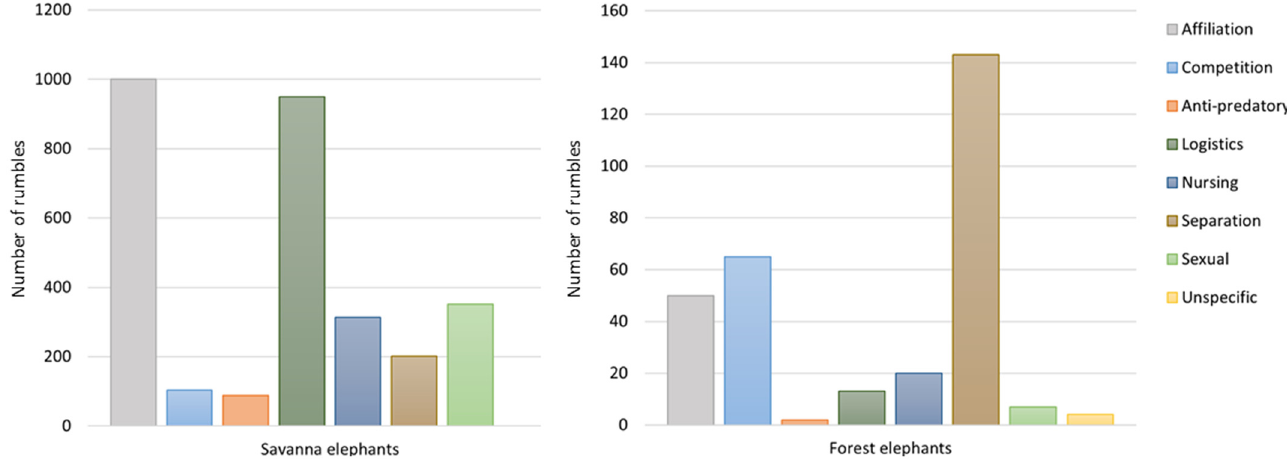
Figure 3. Number of rumbles produced by forest elephants at Dzanga Bai and savanna elephants in seven and eight broad context categories, respectively (savanna elephants: N = 3006, forest elephants: N = 304).